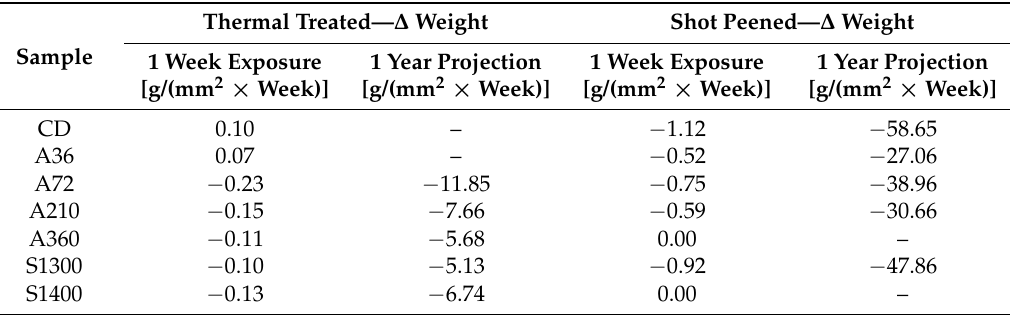
Table 7. Results of the salt spray fog